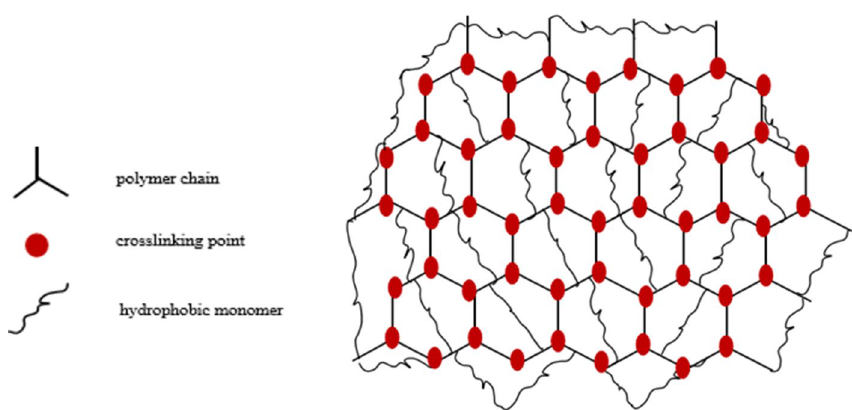
Figure 7. Cross structure diagram of polymer PLY-F reinforcement